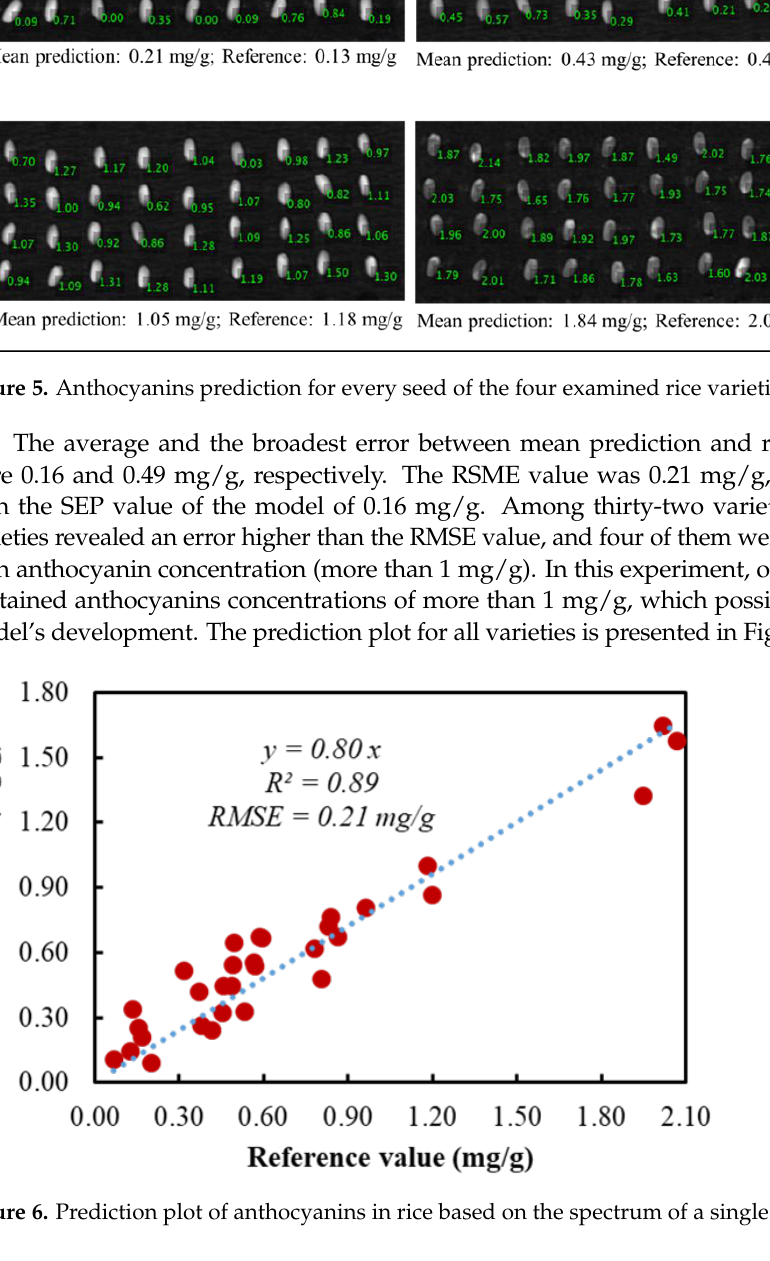
Figure 6. Prediction plot of anthocyanins in rice based on the spectrum of a single seed.